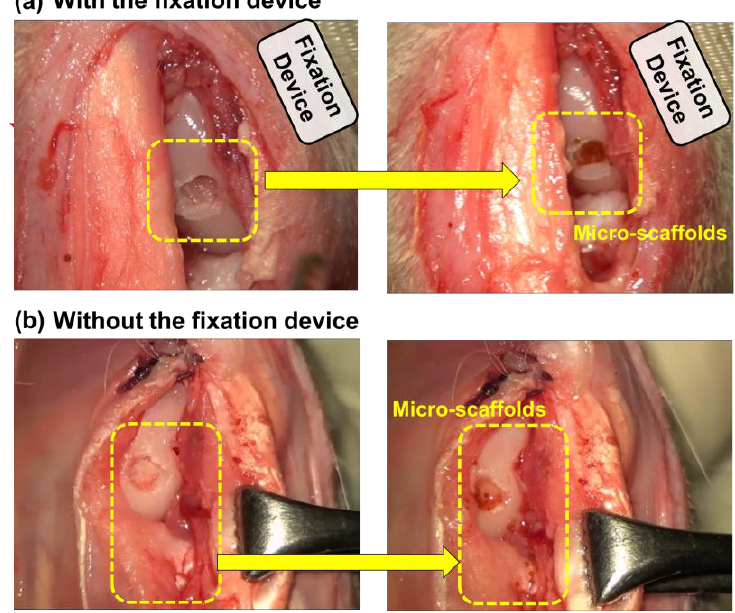
Figure 10. Results of the in-vivo experiment involving the injection of micro-scaffolds. ( a ) with the fixation device: the MCTAC remains fixed at the target defect, and ( b ) without the fixation device: the MCTAC flows toward the lower tissues.